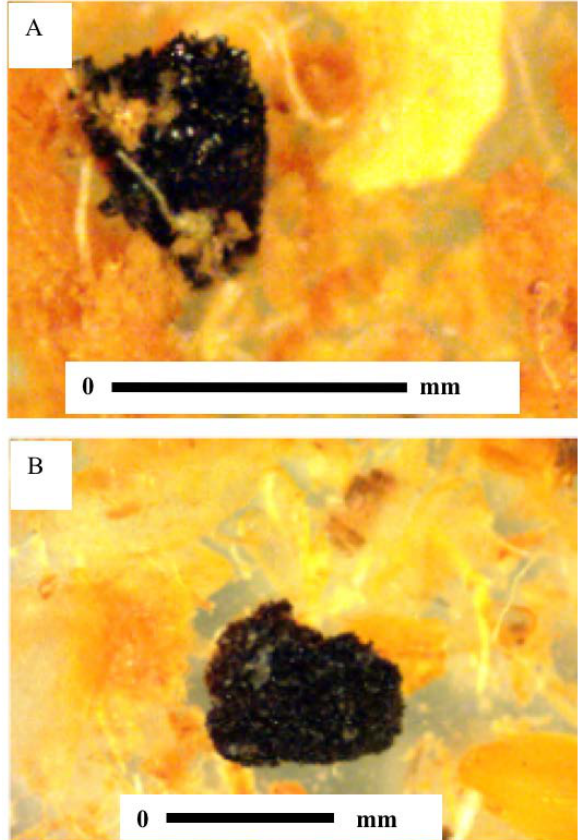
Figure 4. All Saints Bog charcoal abundance. Black dots represent the depths at which peat was sampled through the core and the red dots represent the samples in which charred peat aggregates were found.